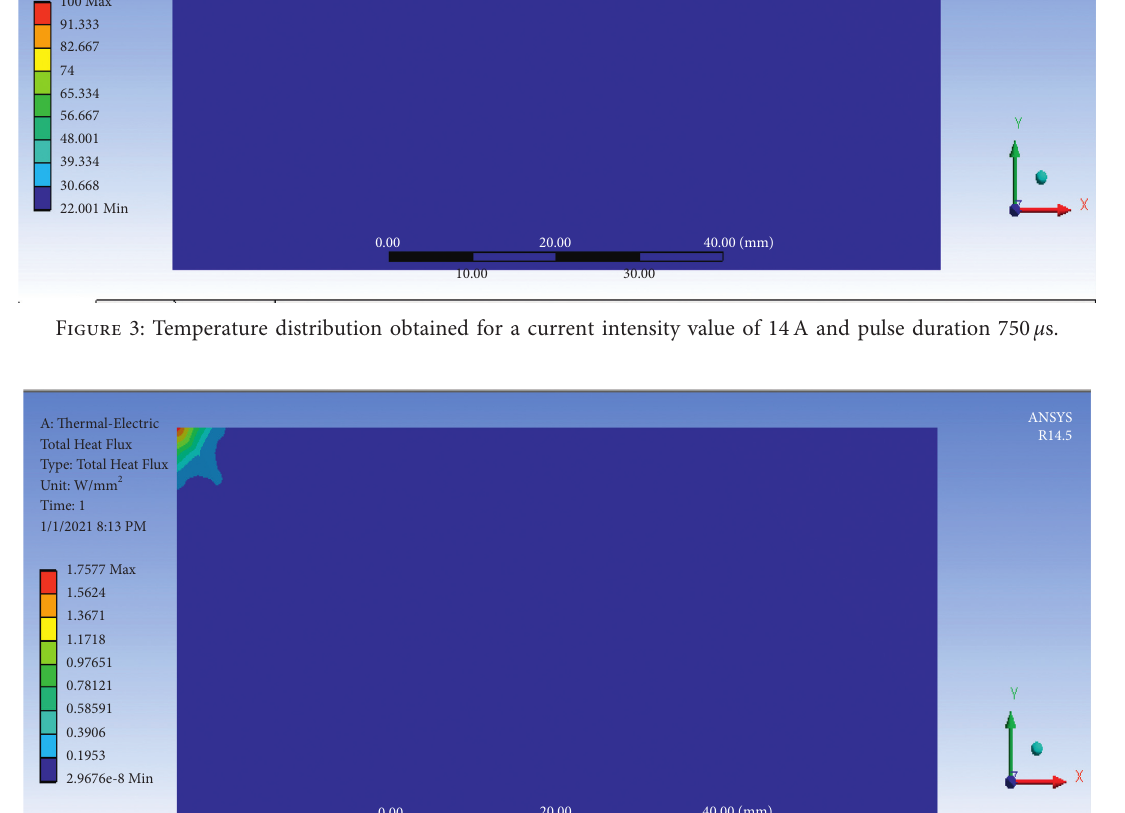
Figure 4: Volume of material removed for current intensity value of 14A and pulse duration 750 μ s.